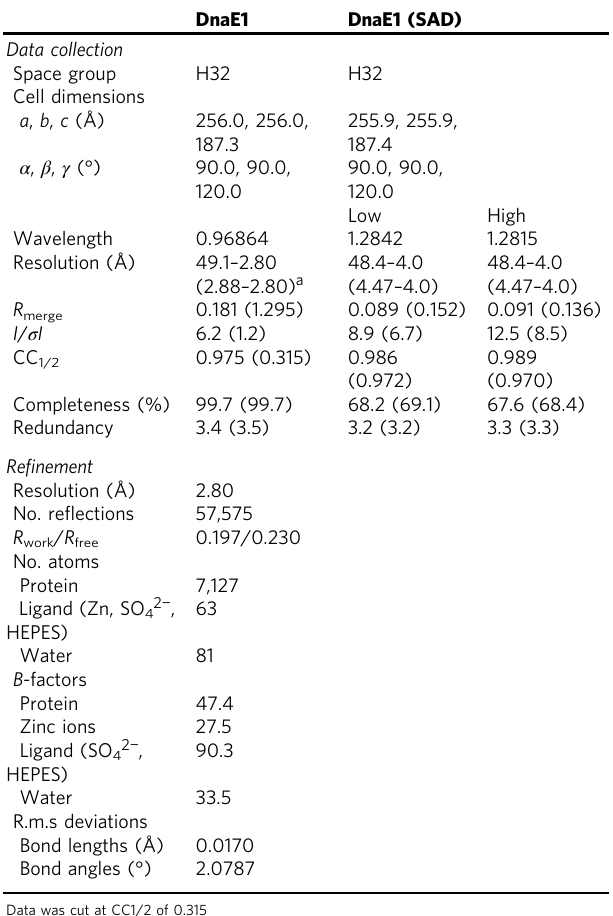
Table 1 Data collection and re fi nement